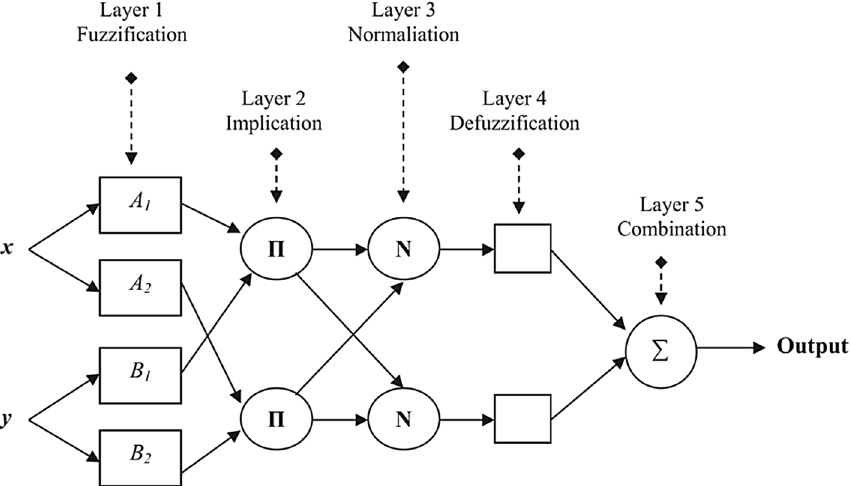
Fig. 4 The basic structure of